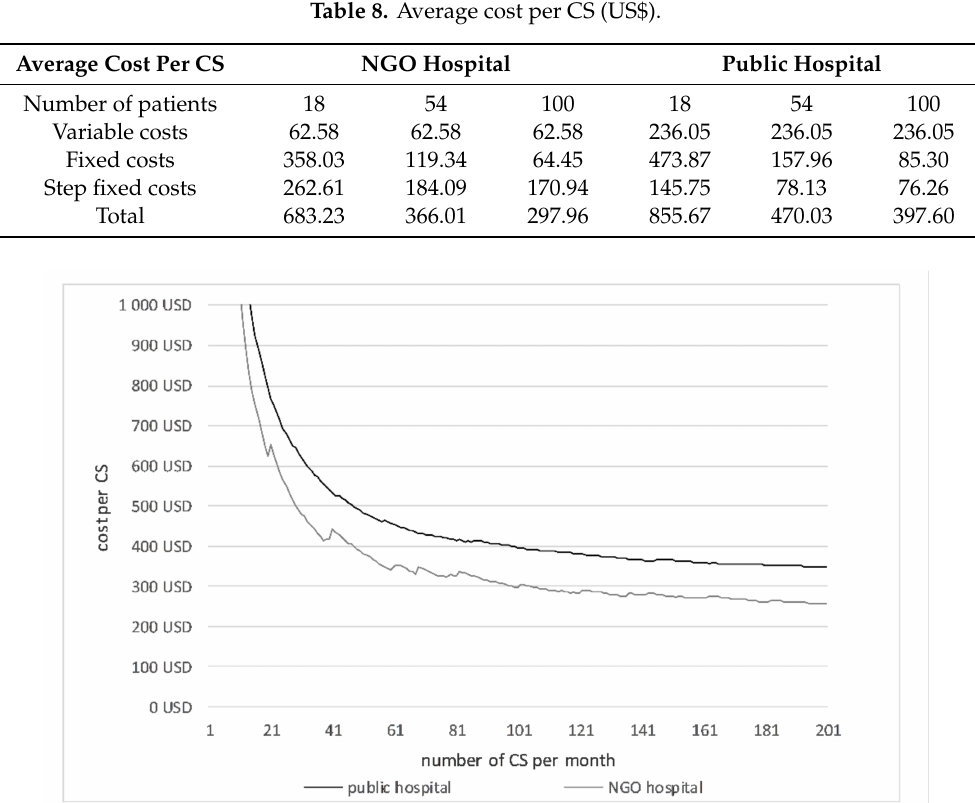
Figure 2. Average cost per